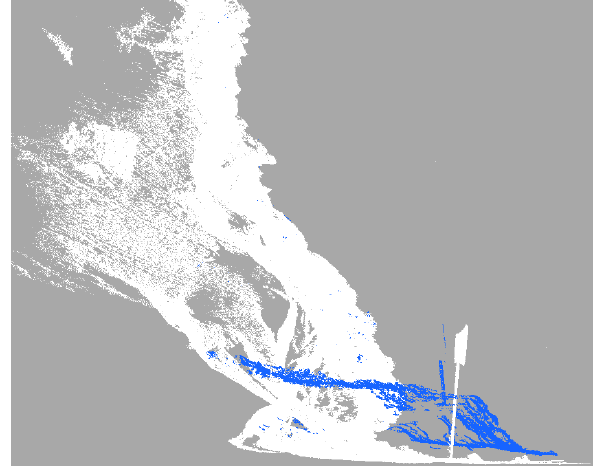
Figure 6: Deposition on north-end of the study site, focus is on a new terrace that was